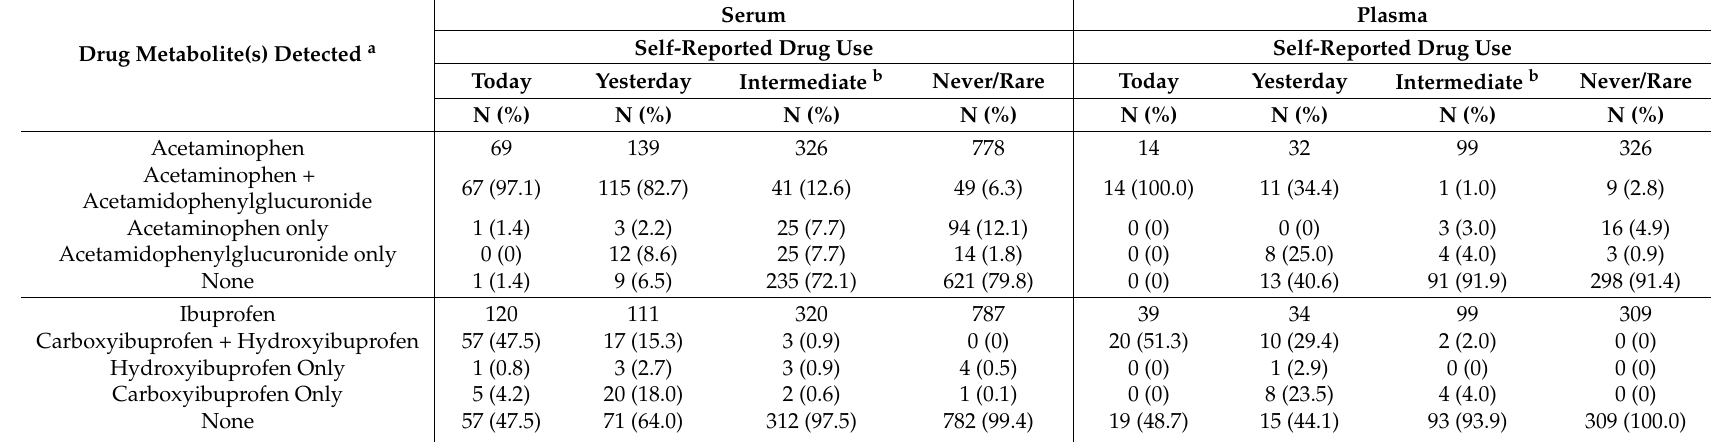
Table 1. Comparison of self-reported acetaminophen and ibuprofen use and detection of specific metabolites in plasma and serum samples.